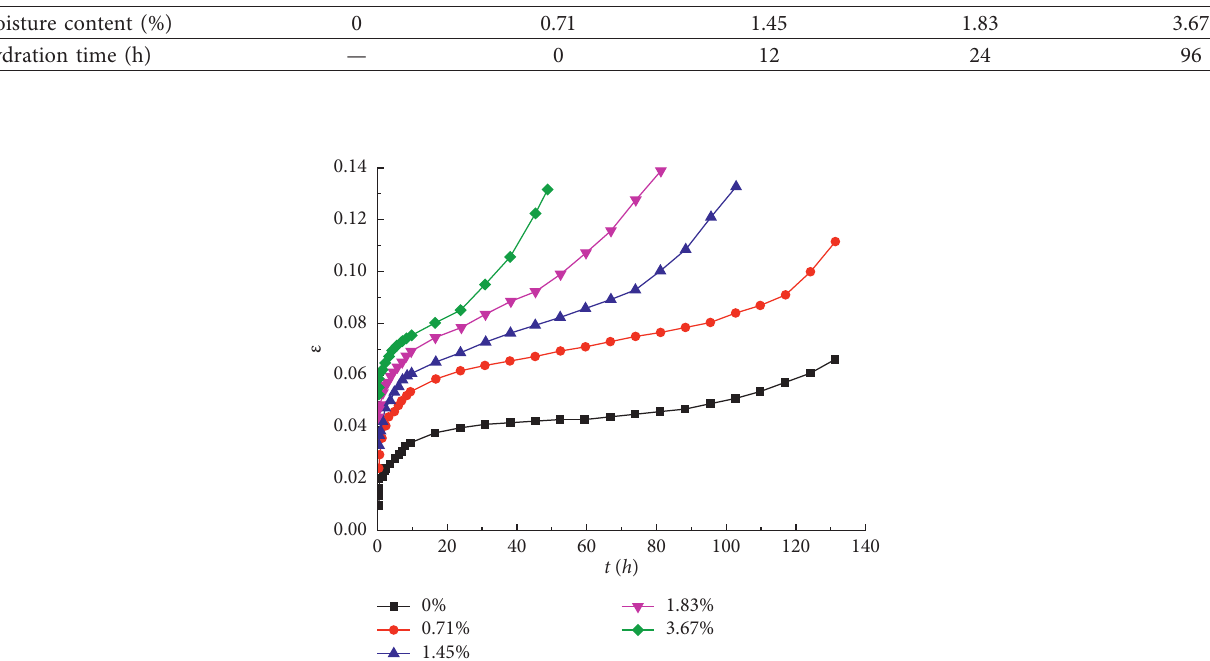
Figure 7: Equipment and schematic diagram of the experiment: (a) machine for static oil pressure testing; (b) schematic diagram of the creep test. Table 1: Moisture contents and hydration times.